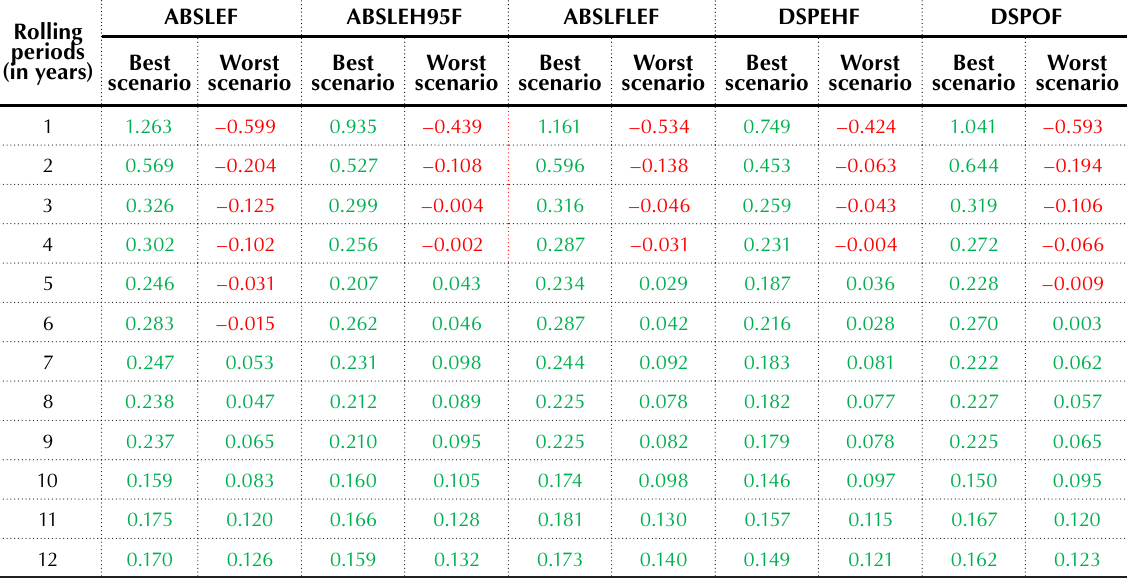
Table 6. Rolling period CAGR (in %) for ABSLEF, ABSLEH95F, ABSLFLEF, DSPEHF, DSPOF schemes